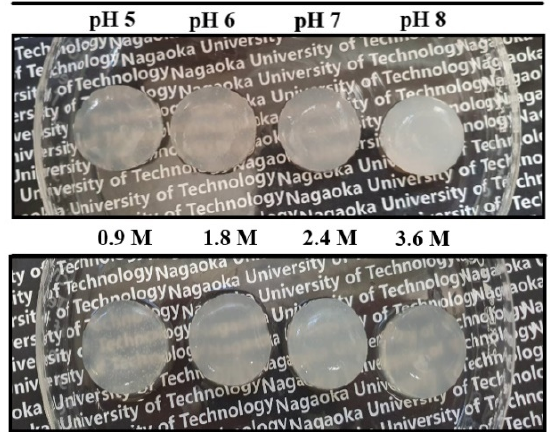
Figure 3. Appearance pictures of calcium – pectinate hydrogels prepared with different CaCl 2 con- centrations at various